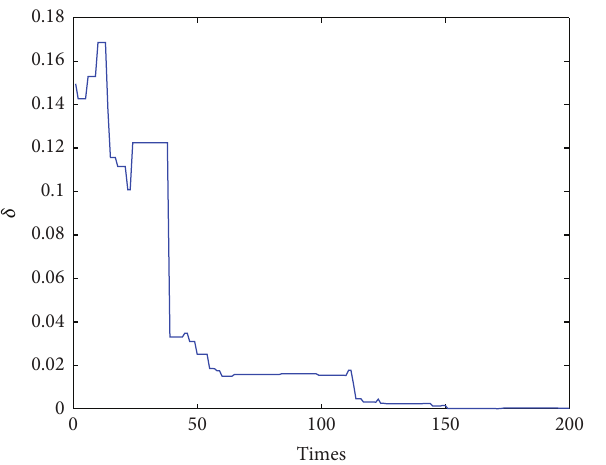
Figure 4: The error 𝛿 of parameters estimation versus Times .